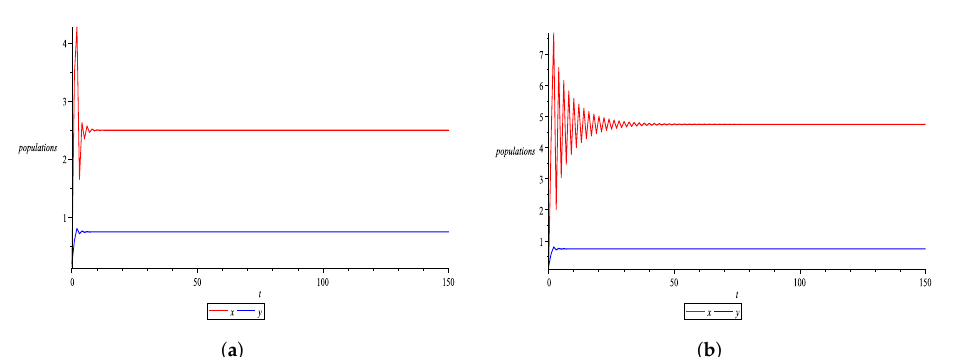
Figure 2. Bifurcation diagrams of system (3). ( a ) α = 1.5, β = 0.4, γ = 1.5, δ = 2,0 < c < 3; ( b ) α = 1.5, β = 0.4, γ = 2.5, δ = 2,0 < c < 2; ( c ) α = 4, β = 0.4, γ = 1.5, δ = 2,0 < c < 6;